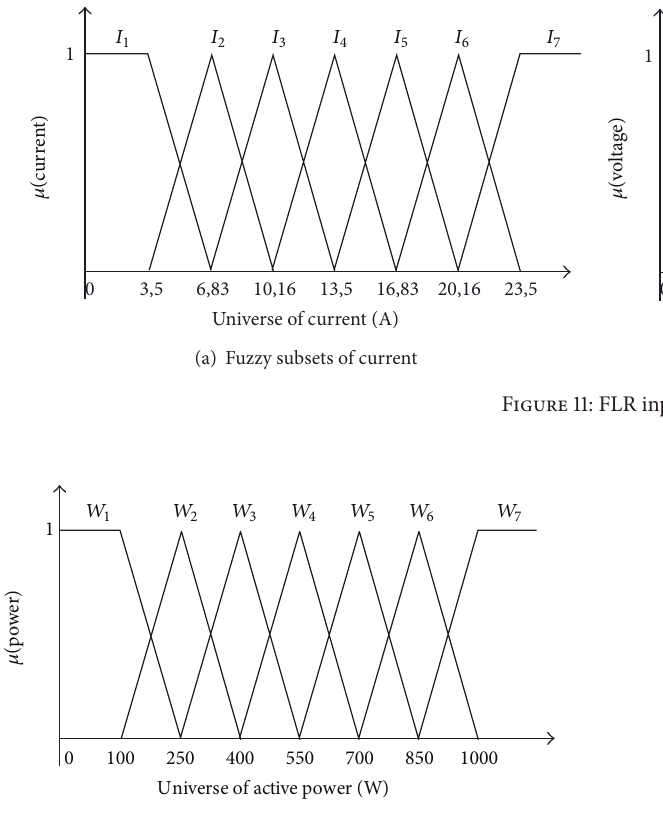
Figure 12: Fuzzy subset of power output spaces.